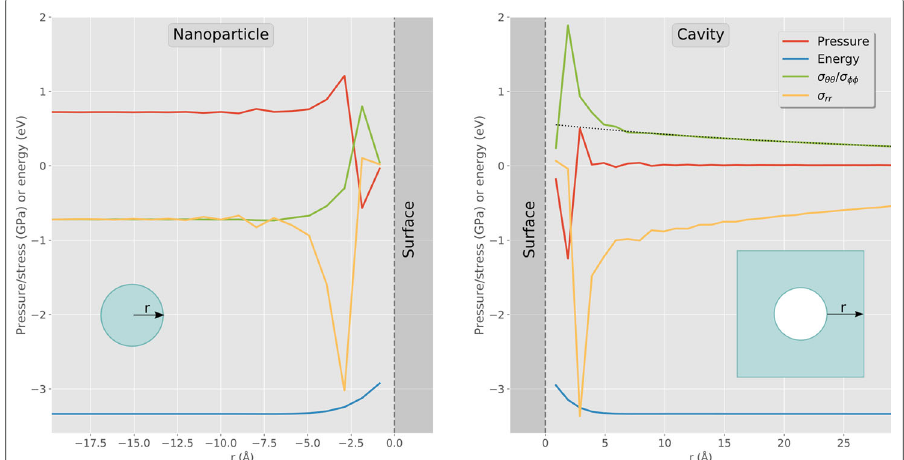
Fig. 2 Example of atomic energy, pressure, and diagonal stress tensor components variations in a 20 nm diameter aluminum nanoparticle (left) and cavity (right) as a function of the radial distance from the center, for two arbitrary applied pressures. All quantities are radial averages made in 1 Å thick shells. The vertical dashed lines indicate the position of the surface assuming perfectly spherical systems and a surface atom volume equal to the bulk atomic volume. The dotted line is a fit made with the expression α/ r 3 and excluding data close to the